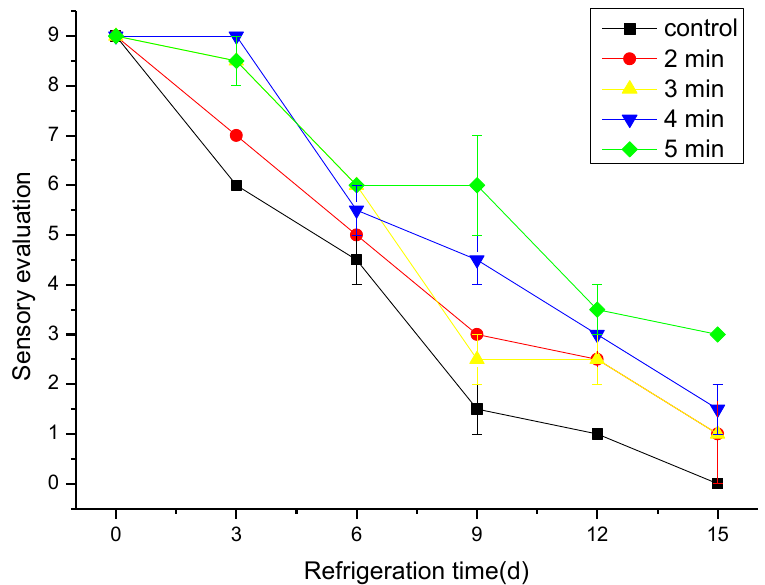
Figure 6. Sensory evaluation of cold stored hairtail fish exposed to CAP at 50 kV voltage for various treatment times: 2, 3, 4, and 5 min. The non-treated sample was included as a control.